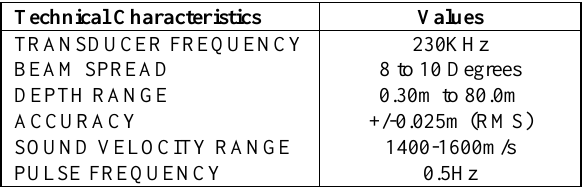
Table 2. Technical Characteristics of the